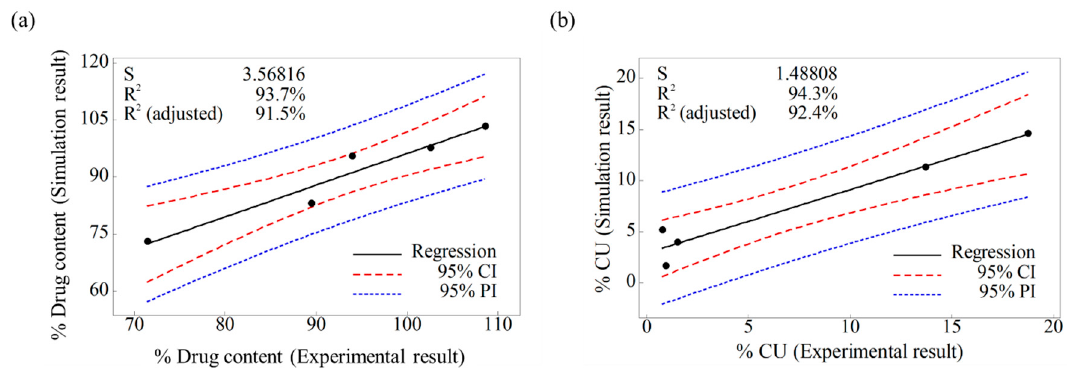
Figure 9. Fitted line plots for the experimental and simulation results at laboratory-scale: ( a ) drug content (%) and ( b ) CU (%). Black line, red dotted line, and blue dotted line denote regression, 95% confidence interval (CI), and 95% prediction interval (PI), respectively.